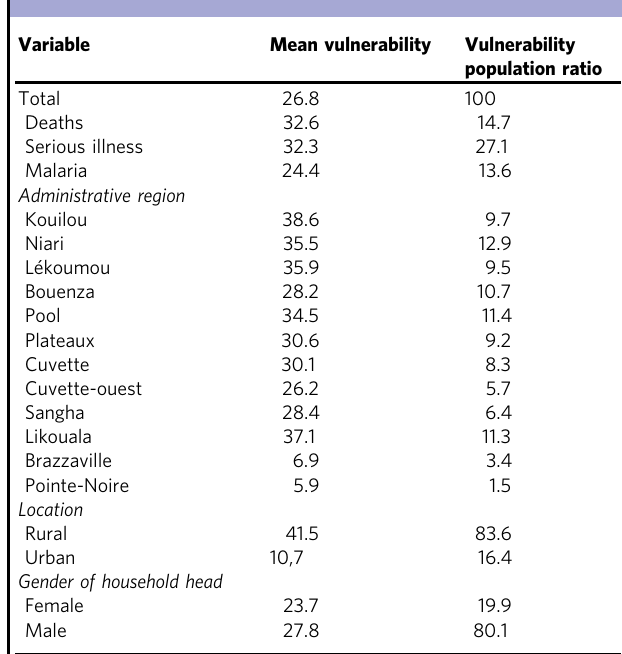
Table 3 Mean vulnerability to poverty by household